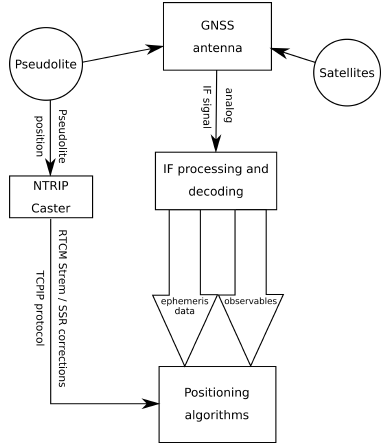
Figure 1. Concept of RTCM pseudolite corrections data